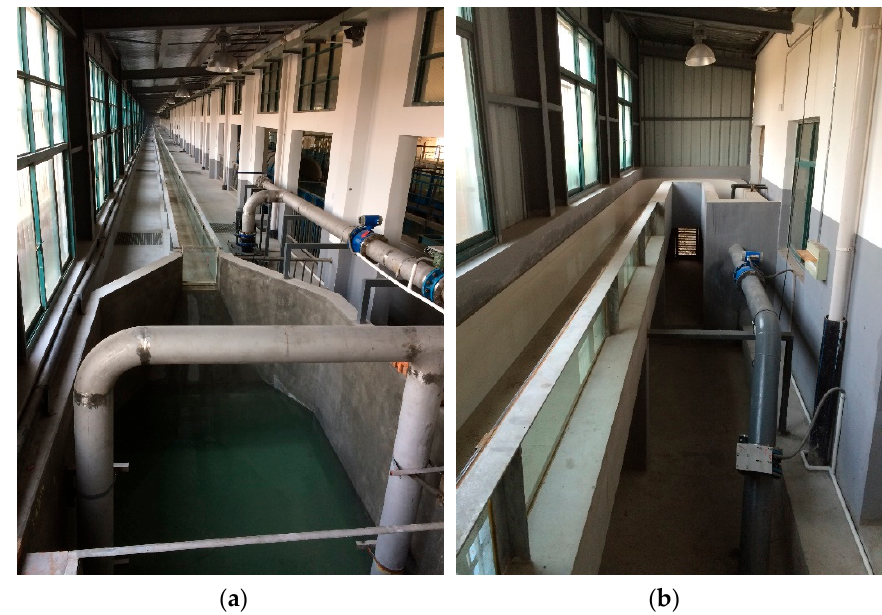
Figure 2. Photographs of both ends of the flume. ( a ) Downstream layout of the flume; ( b ) Upstream layout of the flume.